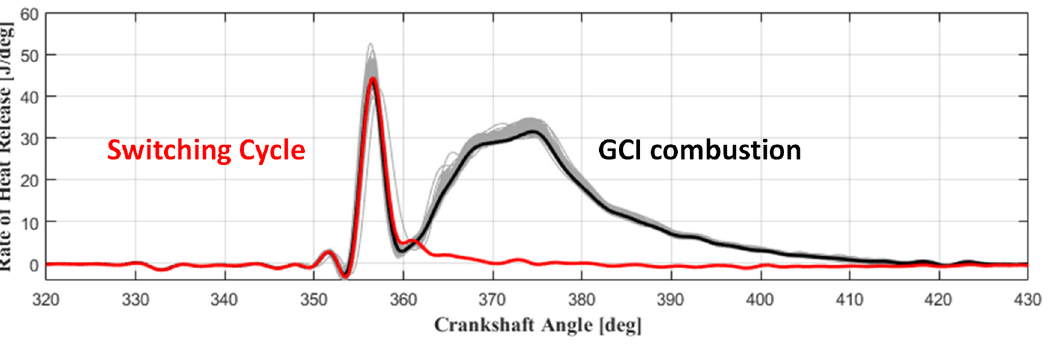
Figure 5. Comparison between average RoHR running the engine with the complete injection pattern (black) and RoHR of the switching cycle (red).